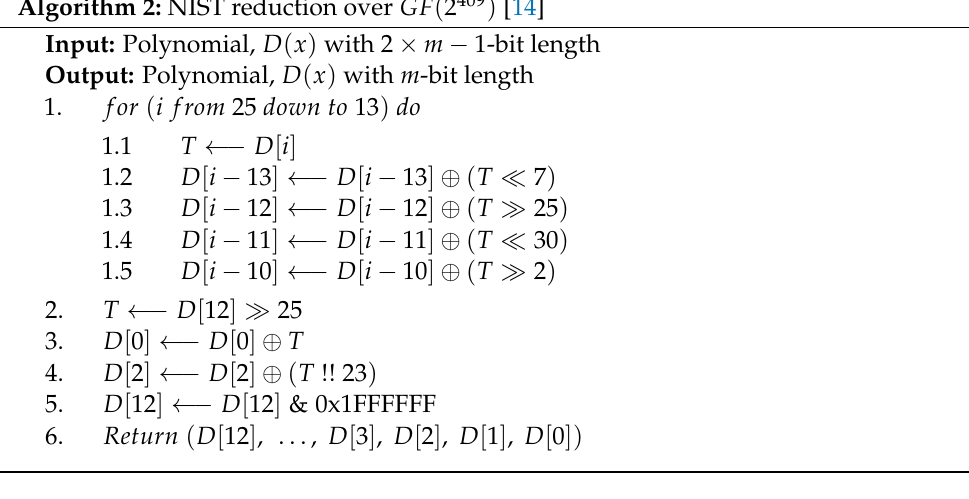
Algorithm 2: NIST reduction over GF ( 2 409 ) [14]